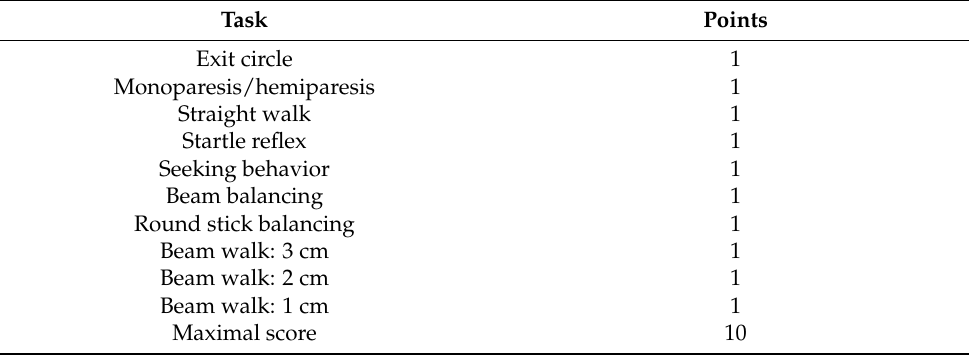
Table 1. Neurological Severity